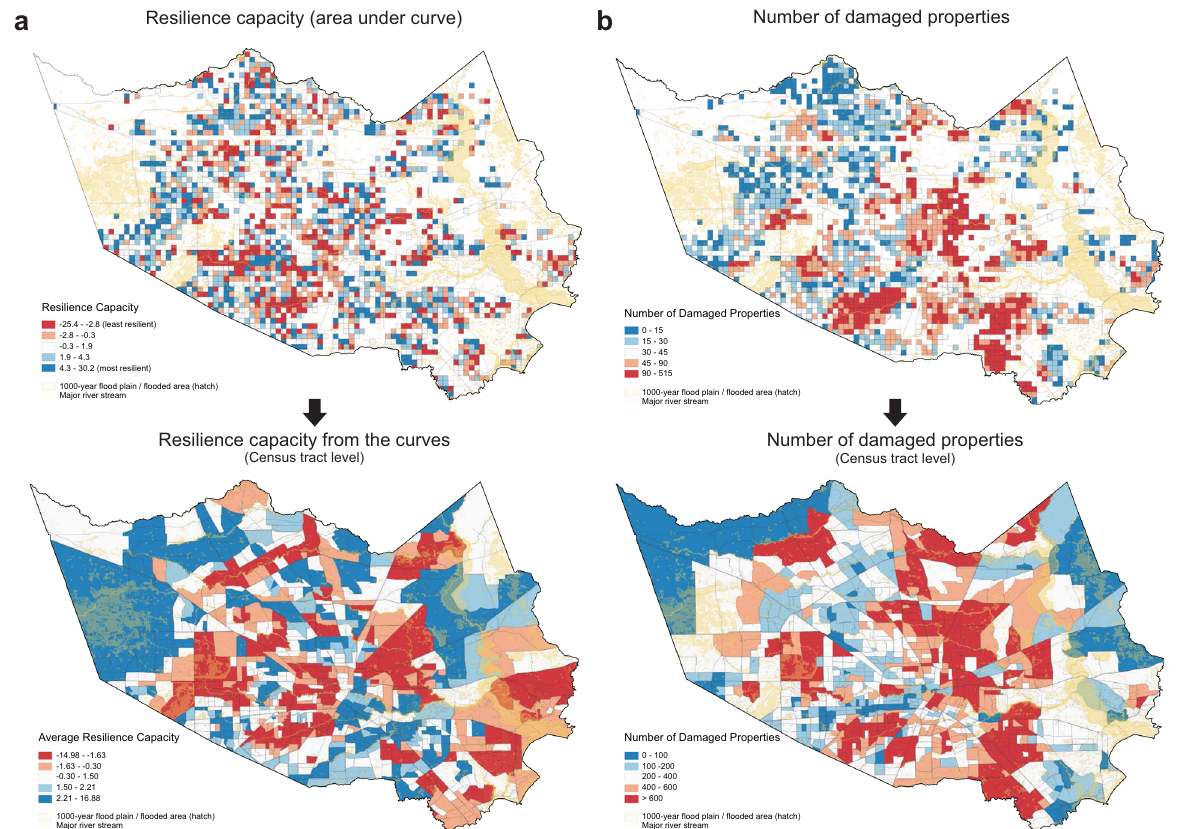
Fig. 2 Validation of neighborhood resilience measure. a Neighborhood resilience capacity calculated as the area under the curve (AUC) represented in ( a ). Top is grid cell and bottom is aggregation to the census tract. Red colored neighborhoods are less resilient, while blue colored cells are more resilient. b The number of damaged properties based on the Federal Emergency Management Agency (FEMA) disaster assistance application data are illustrated at two different spatial resolutions (grid cell and census tract). Residents in red colored areas experienced more severe property